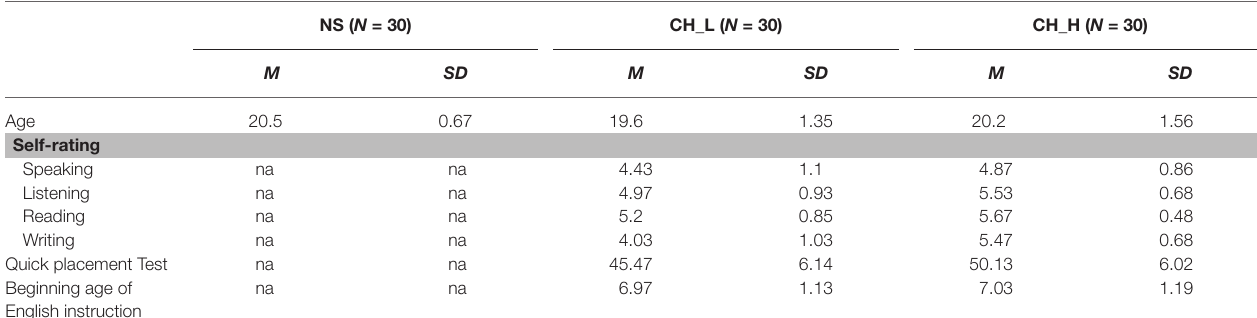
TABLE 2 | Participant profile